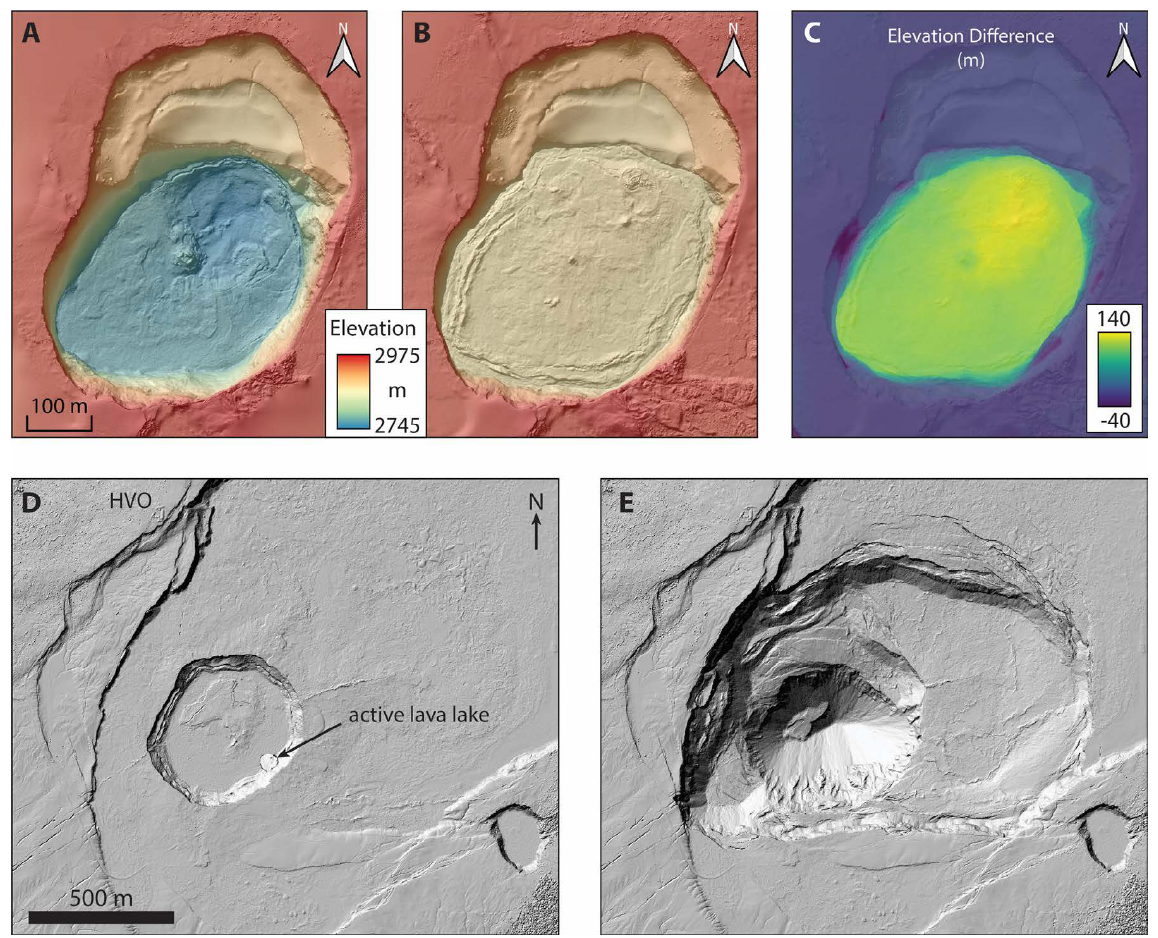
Figure 10: Topographic change due to crater filling [A–C] and caldera collapse [D–E]. 8-cm resolution DEMs of the pit crater in the NE part of the Nyamulagira summit caldera, D. R. Congo, in [A] June 2017 and [B] October 2018, capture an elevation change [C] due to a lava accumulation of ~2.3 × 10 6 m 3 [Smets et al. 2018]. DEMs were derived from SfM-based photogrammetry, with images captured using DJI Phantom 4 (2017) and 4-PRO (2018) quadcopters. Reproduced from Smets et al. [2018]. The summit caldera collapse at K¯ılauea, 2018, is illustrated by shaded relief images from a [D] 2009 LiDAR survey (1-m resolution) and [E] post-collapse UAS photogrammetry survey (11 August 2018, 15-cm resolution). HVO marks the Hawaiian Volcano Observatory buildings and infrastructure, now closed. UAS surveys provided unprecedented monitoring of caldera growth including sequential DEMs bracketing a single collapse event. The summit underwent ~825 × 10 6 m 3 of volume loss (~12.4 × 10 6 m 3 per day), with maximum subsidence exceeding 500 m in the central part of the caldera [Diefenbach et al.